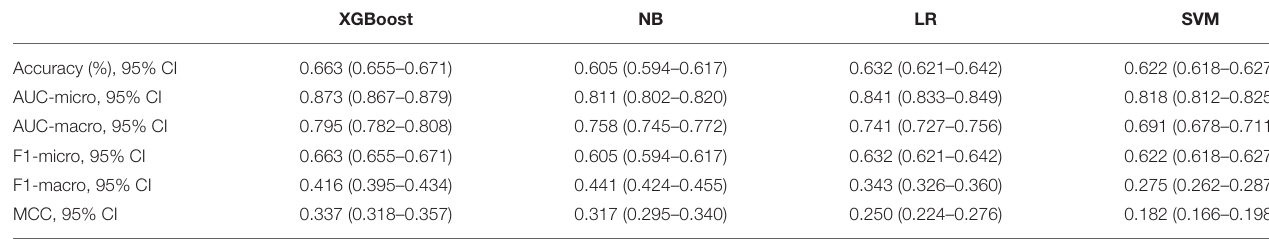
TABLE 2 | Performance of the four prediction